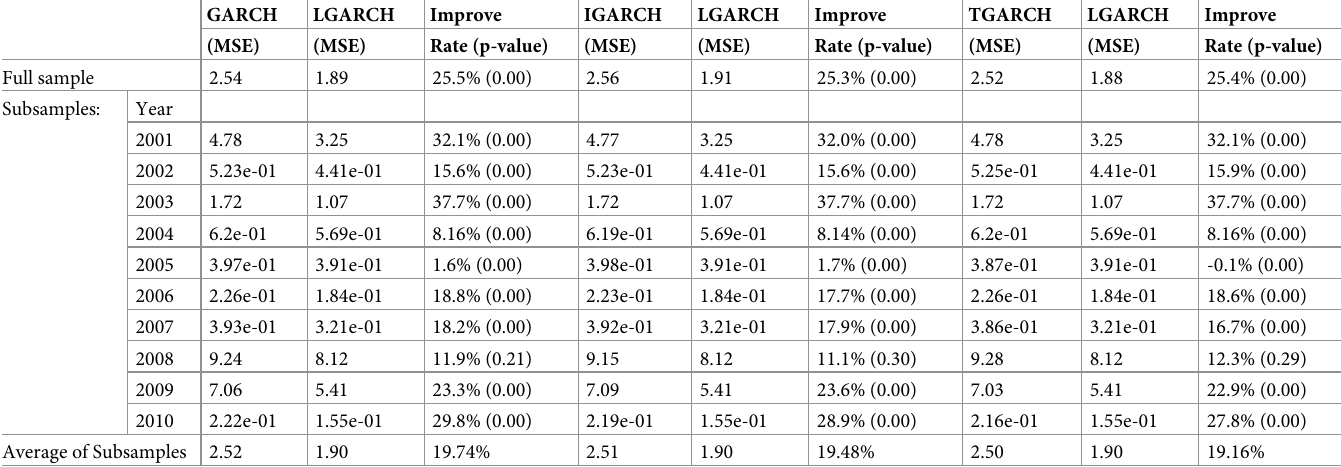
Table 3. In sample fitting with simplified realized variance. This table presents the oil futures volatility in-sample fitting results of Liquidity-adjusted GARCH (LGARCH) with other three GARCH models against the simplified realized variance using the Mean Squared Error (MSE). The p-values for statistical differences of the forecasting errors are also presented. The LGARCH model outweighs all other three models in both full sample and most subsample tests except year 2005 compared with TGARCH. Where en = � 10 n , e.g. e − 02 = � 10 − 2